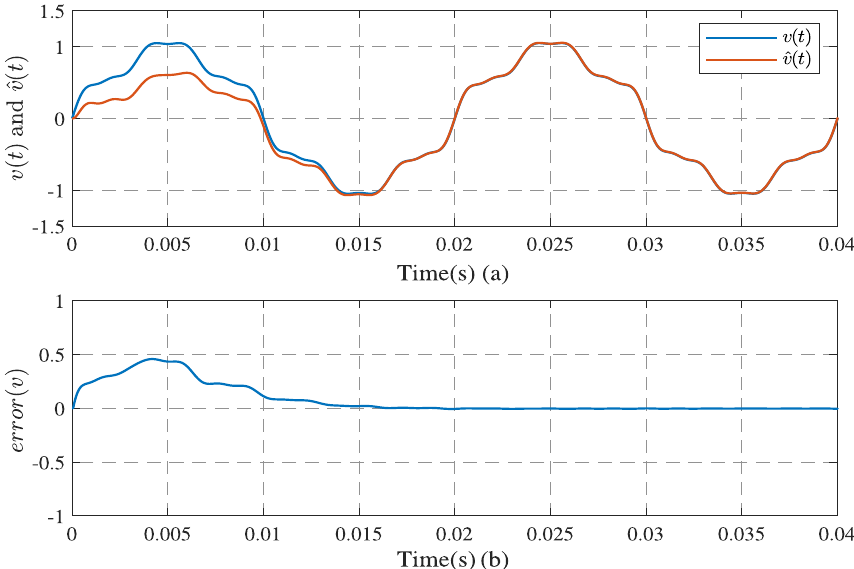
Figure 4. Tracking of the input signal and error. ( a ) Tracking of the input signal and ( b )